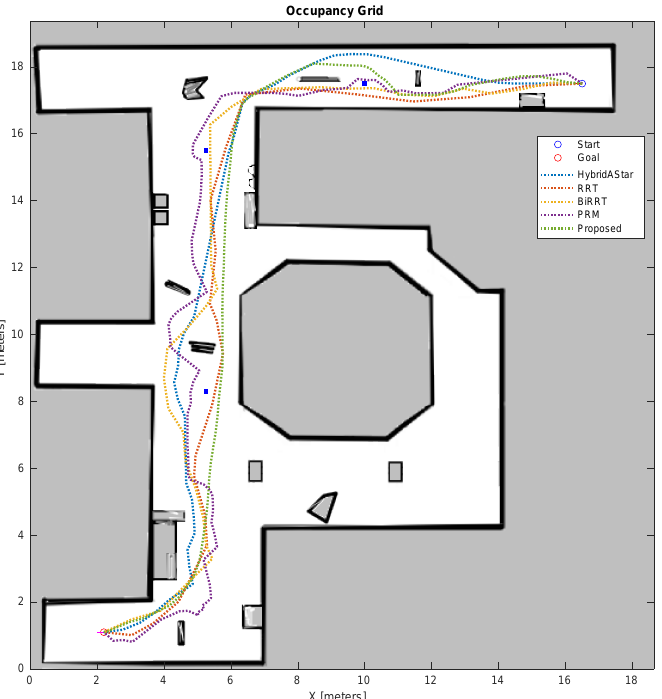
Figure 10. Paths obtained during the navigation on a static obstacles